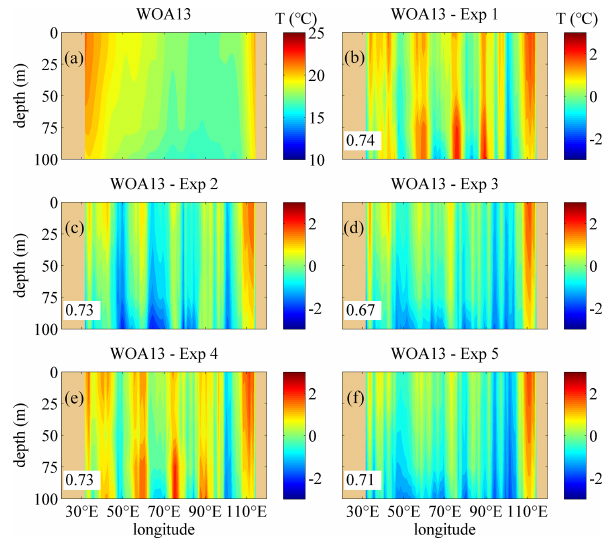
Figure 5. The same as Fig. 4, but in July.